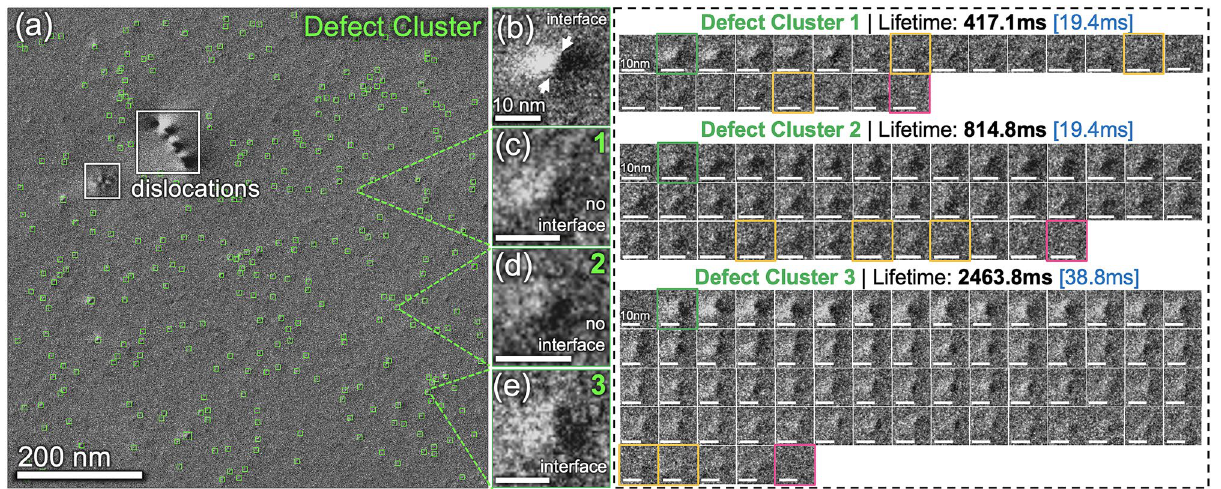
Figure 1. Representative defect clusters in a snapshot of an in-situ TEM video acquired during 1 MeV Kr 2+ ions (right). In-situ TEM image series of three selected defect clusters with different lifetimes. The time interval between frames marks in blue. In these sequences, the green outlined frames indicate when a defect